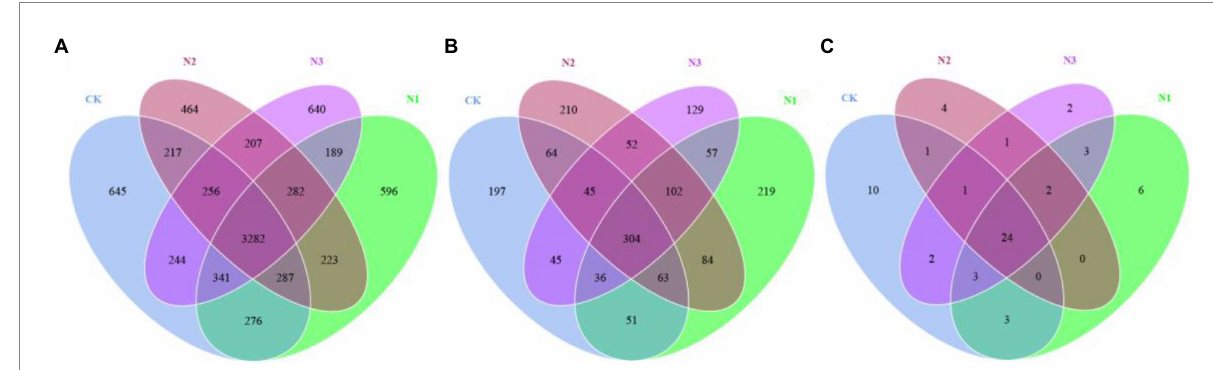
FIGURE 1 Venn analysis of the soil microbial community in different N deposition treatments based on OTU levels. (A) The number of bacterial OTU at different N treatments. (B) The number of fungal OTU at different N treatments. (C) The number of archaeal OTU at different N treatments. Each ellipse represents a treatment in the figure, and the number of shared OTUs between treatments is represented by the number of overlapping parts, while the number of non-overlapping parts represents the number of unique OTUs between treatments.